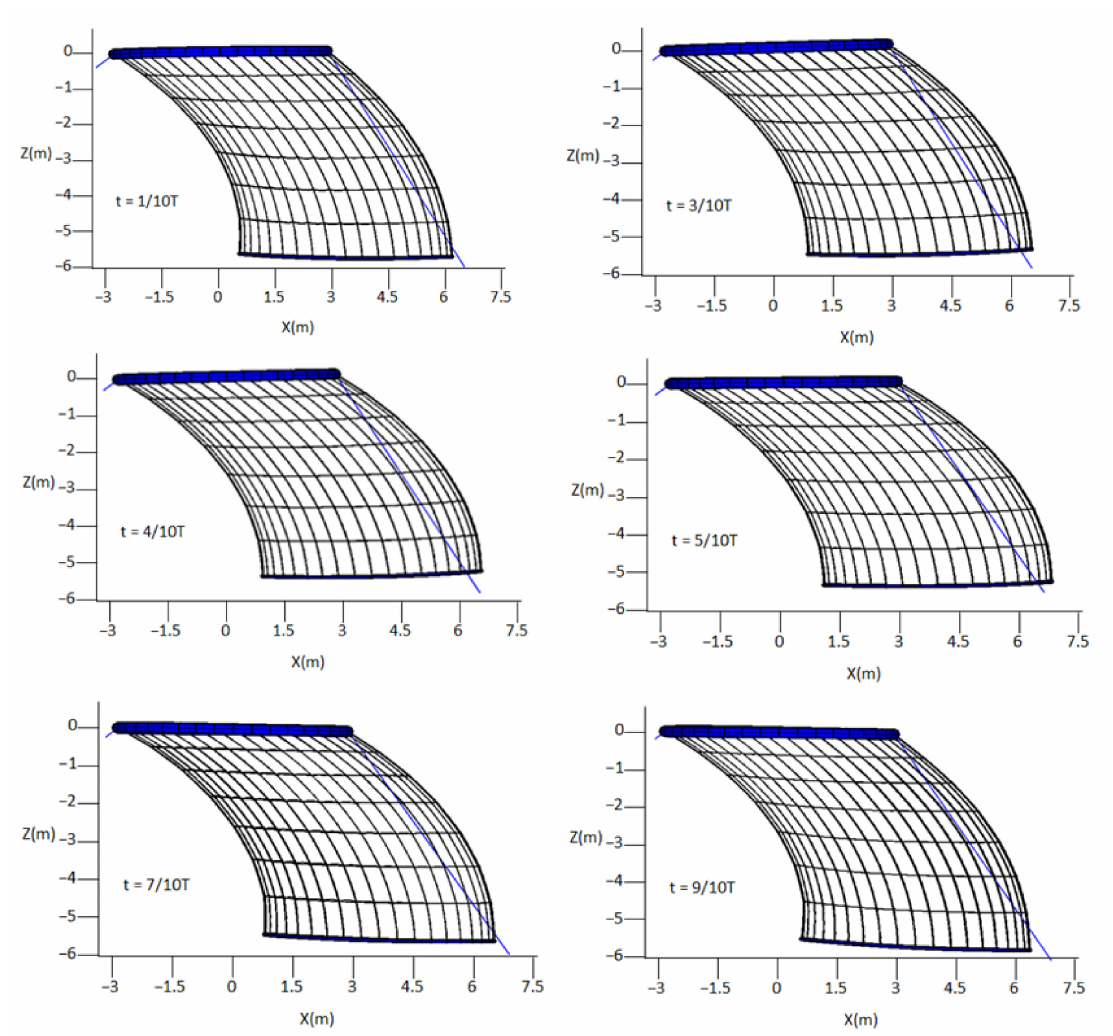
Figure 6. Cage deformation representing the net deformation for different times with a wave height = 1 m, wave period = 10 s, and current speed u = 0.5 m/ s , and the other parametric values are the same as defined in Table